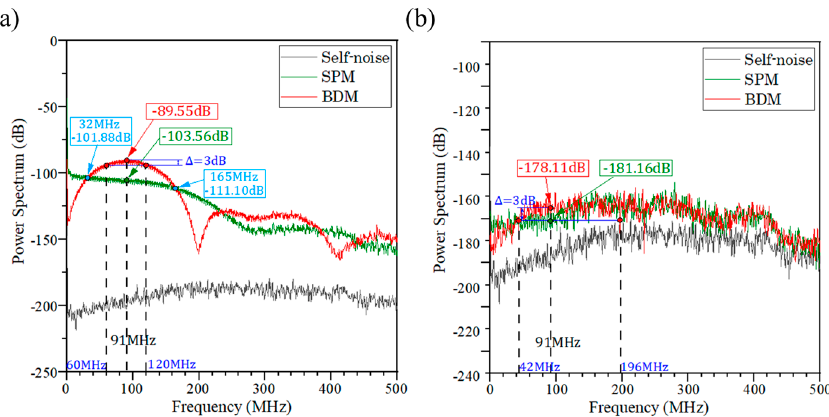
Figure 8. Power spectra of the signals sampled by the two methods for laser output peak powers of ( a ) 100 mW and ( b ) 5 mW. ( a ) 100 mW and ( b ) 5